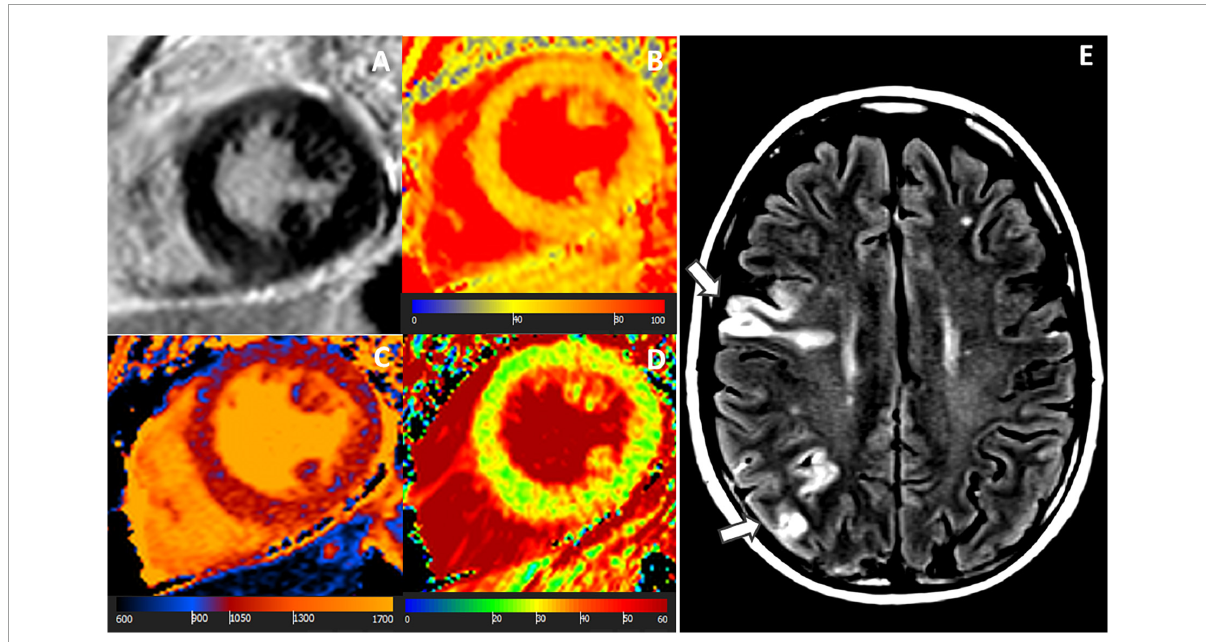
FIGURE2 A 58-year-old female with ischemic stroke, negative LGE but abnormal mapping values. CMR images: (A) LGE-negative, (B) increased T1 (1,064 ms), (C) increased T2 (56 ms), (D) increased ECV (30%) in an identical midventricular short-axis slice. (E) Cerebral MR showed multiple acute ischemic cortical and sub-cortical lesions in right middle and posterior cerebral artery territories (arrows). Coronary angiography revealed no coronary stenosis.